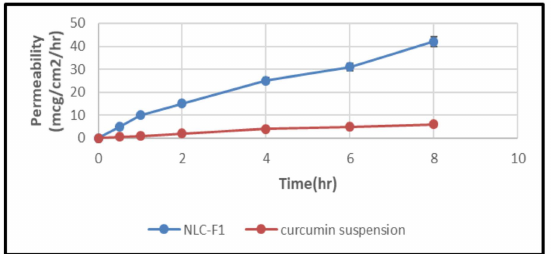
Figure 12. Intestinal permeation study representing permeation of curcumin suspension and curcumin-NLCs versus time (h), mean ± SD (n =